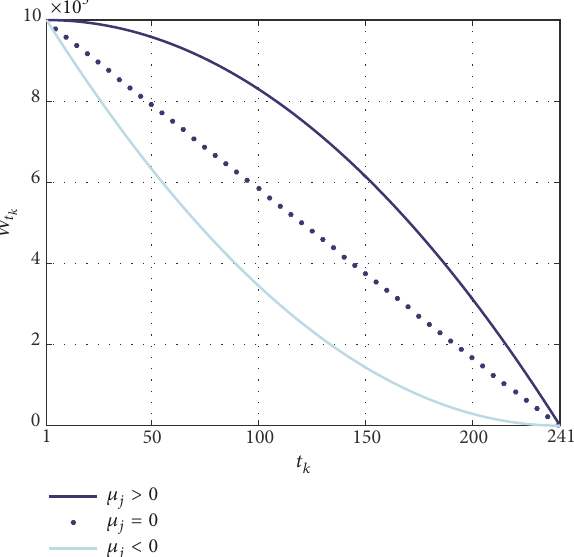
Figure 1: The execution trajectories under different 𝜇 𝑗 .